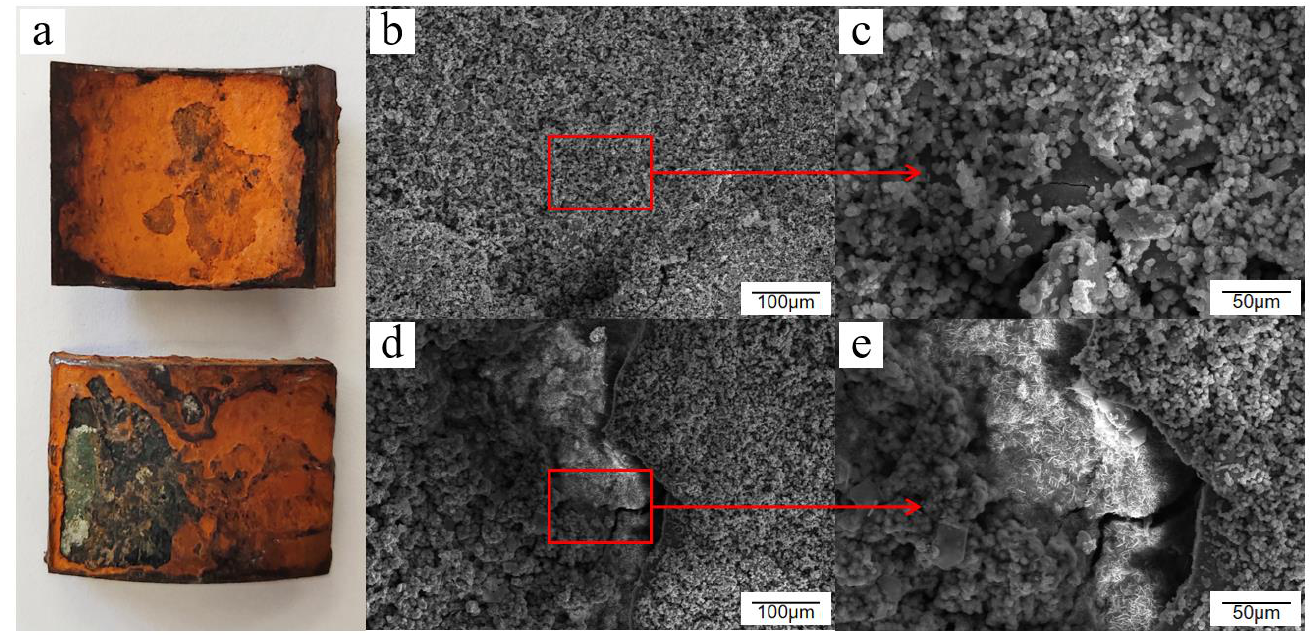
Figure 9. Macroscopic and microscopic morphology of Q235 low-carbon steel after 20 days of expo- sure in the cyclic salt spray accelerated corrosion test: ( a ) macroscopic appearance, ( b ) overall ap- pearance, ( c ) loose corrosion products, ( d ) corrosion layer crack, and ( e ) corrosion intensifies.